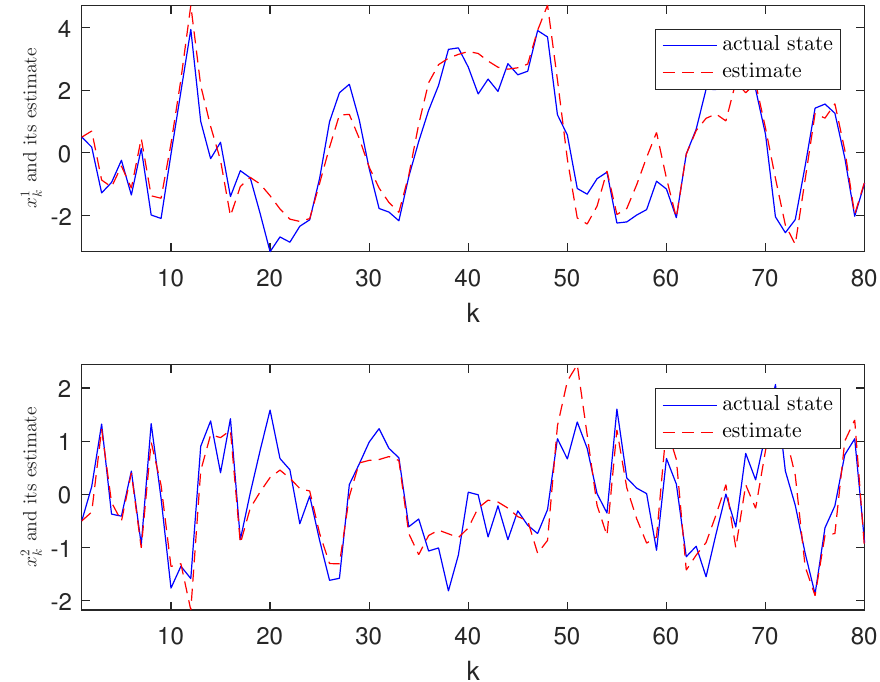
, x 2 and their estimates. k k